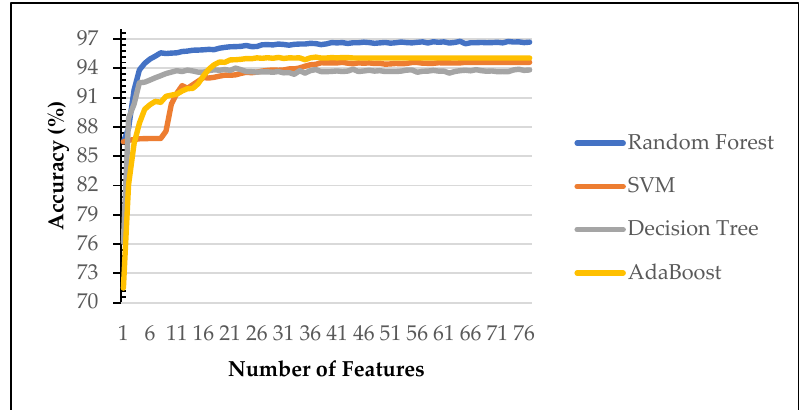
Figure 3. Comparison of various machine learning algorithms for dataset 1.